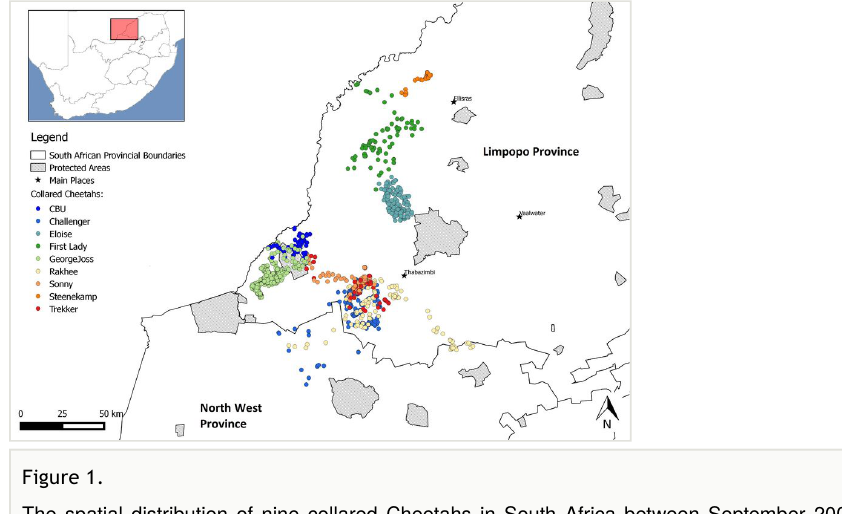
The spatial distribution of nine collared Cheetahs in South Africa between September 2003 and November